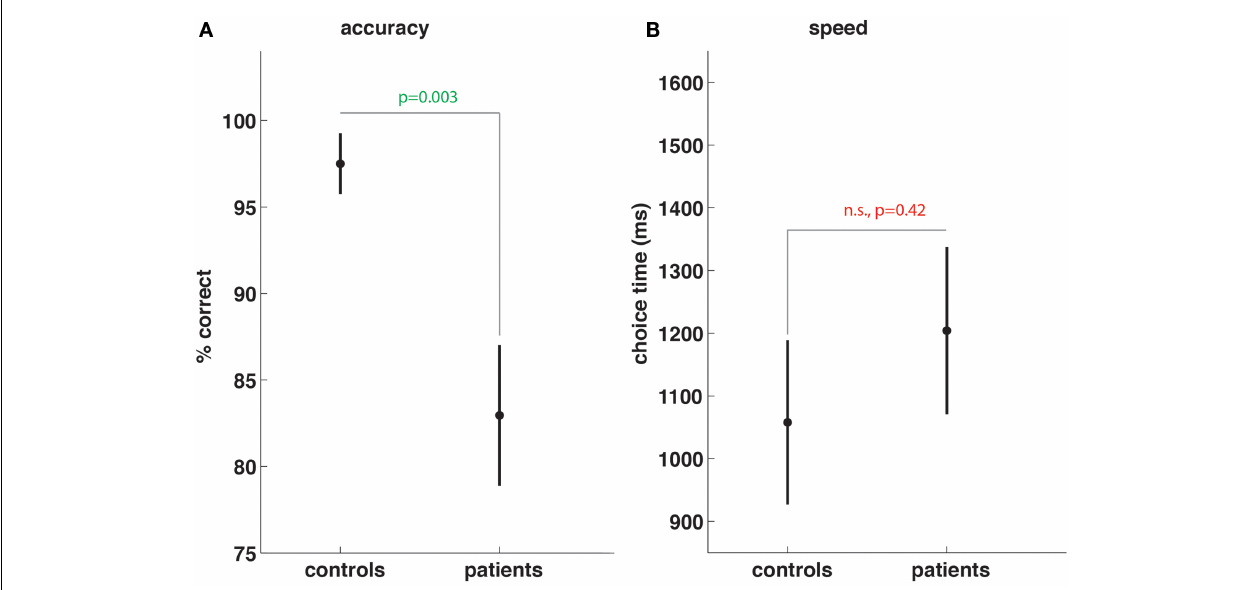
FIGURE 1 | Subarachnoid hemorrhage patients show working memory task impairment . Compared to controls, SAH patients show significant reductions in working memory task accuracy (A) but no significant differences in speed of choices made during memory trials (B) .